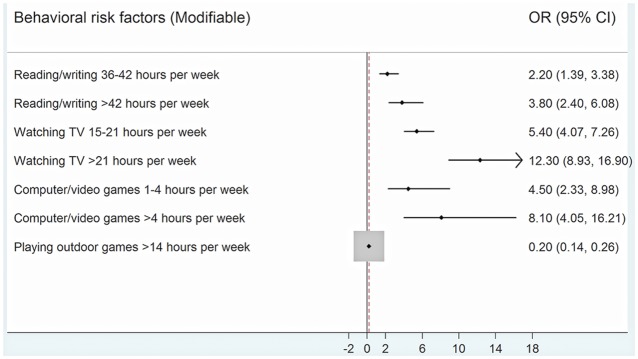
Forest plot showing the odds ratio (95% confidence interval) for each behavioral risk factor adjusted for other behavioral risk factors and demographic variables (age, gender, type of school, family history of glasses, mother’s education and socio-economic status).